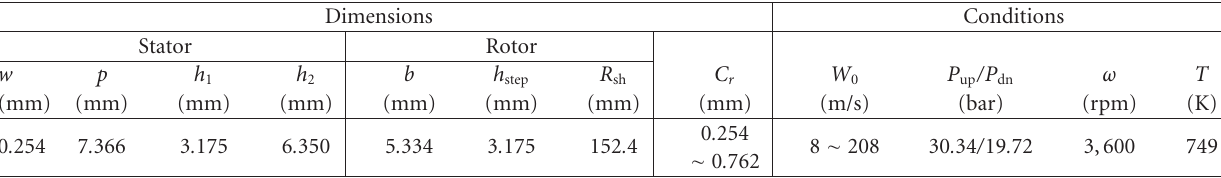
Table 1: Dimensions and conditions for typical high-low labyrinth seals in steam turbines.